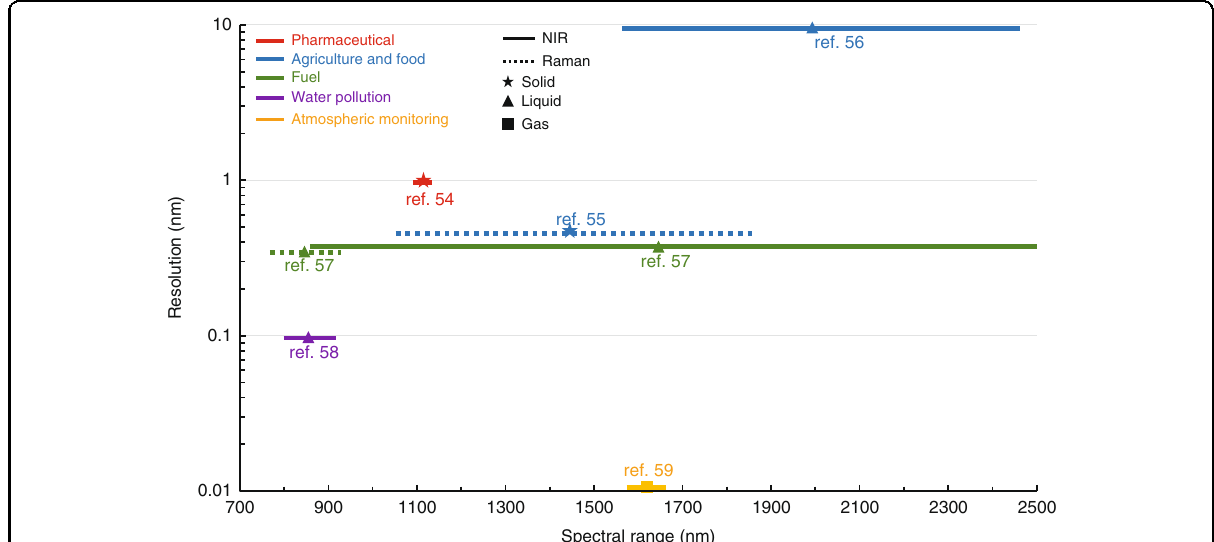
Fig. 5 Summary of the spectrometer speci fi cations for industrial applications based on published demonstrations. Solid and dash line represent NIR and Raman spectroscopy, respectively